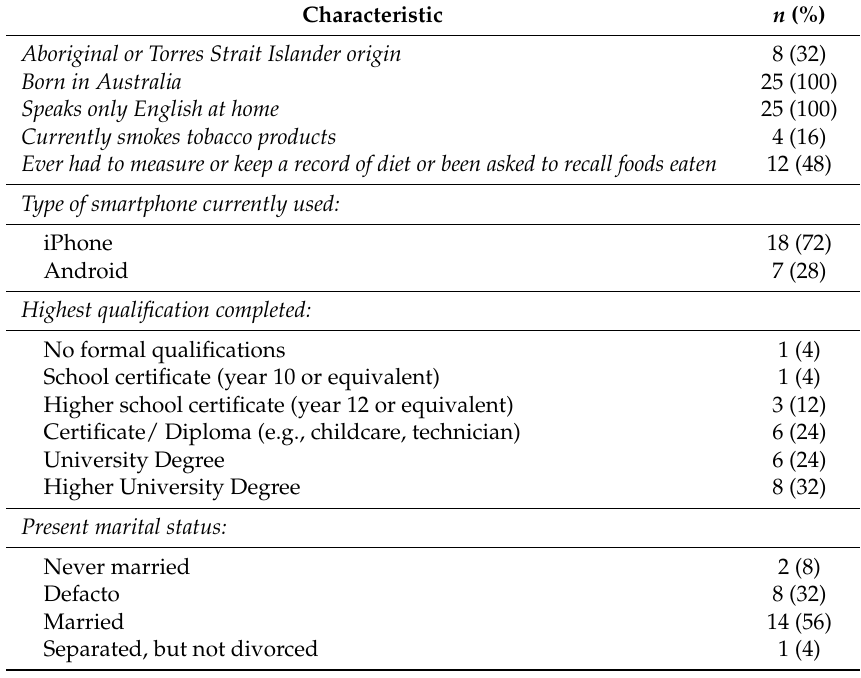
Table 1. Demographic characteristics of participants in the Diet Bytes and Baby Bumps study ( n = 25).